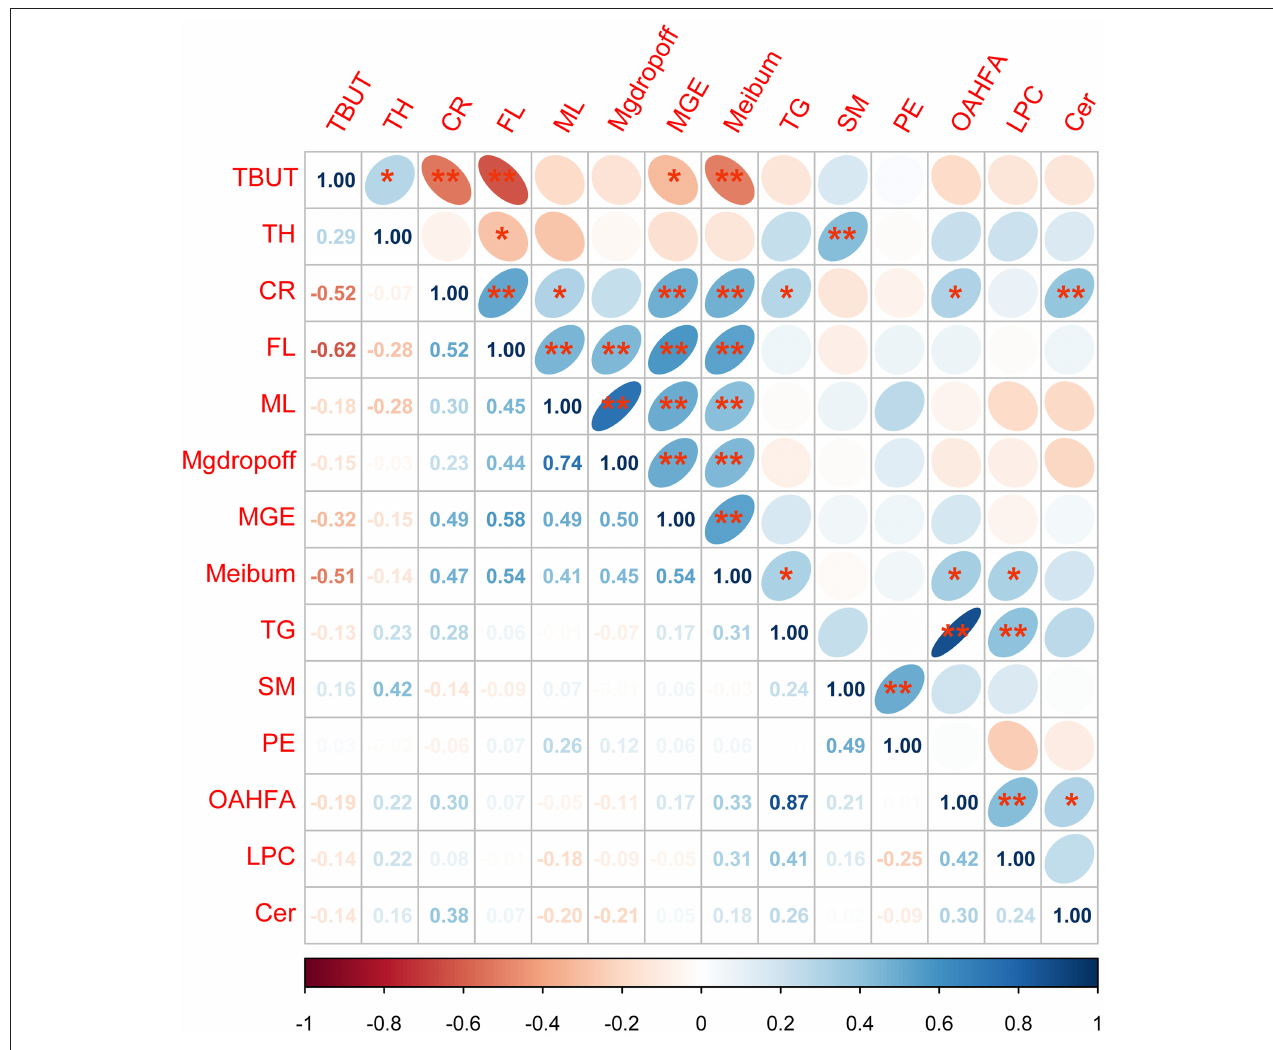
FIGURE 6 | Analysis of the correlation between tear film lipid clusters and ophthalmic clinical indexes. * p < 0.05; ** p < 0.01 Spearman’s correlation analysis between all lipid cluster components and ophthalmic clinical indicators, the lower-left corner number is the r -value of correlation, the darker the color, the stronger the correlation. The ellipse in the upper right corner facing to the left is a positive correlation while facing to the right is a negative correlation. Blue represented a positive correlation between the two indicators, whereas red represented a negative correlation between the two